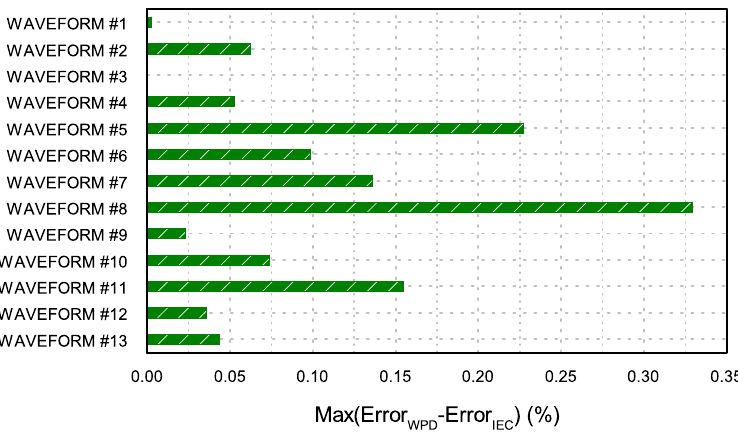
Figure 4. Maximum positive difference between the error of the WPD and grouped IEC methods.